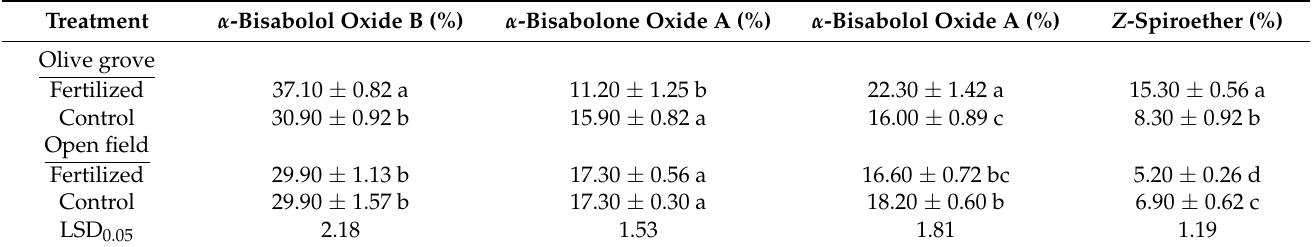
Table 5. Effects of shading and fertilizer application on the essential oil major components (mean ± SD) of chamomile.